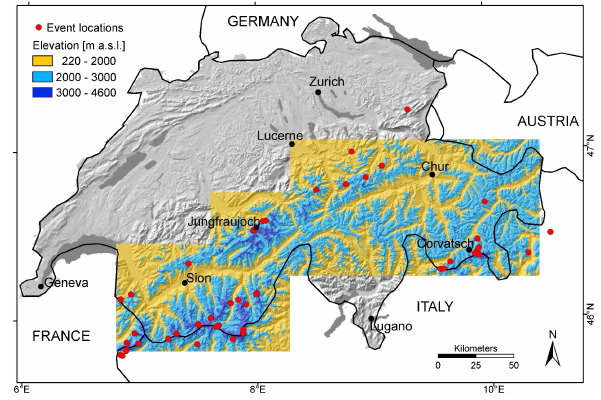
Fig. 2. Location of the recorded rockfall and rock avalanche events (red dots) and marked in blue the investigation area. The area be- low 2000ma.s.l. is not included in the statistical analyses. DHM25 provided by